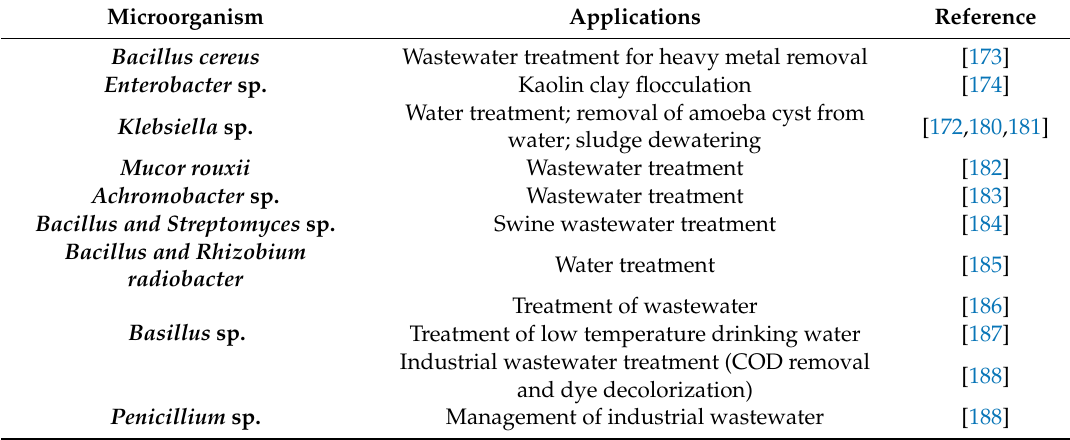
Table 2. Examples of microorganism for bioflocculant production and their potential applications in water and wastewater